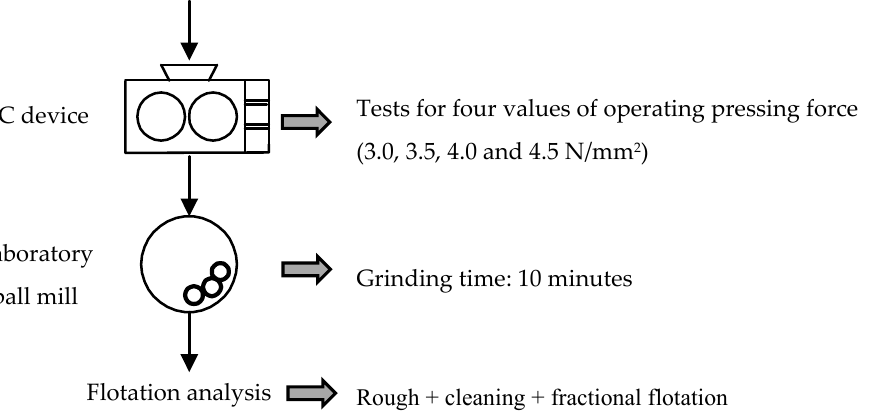
Figure 1. Scheme of investigative programme.